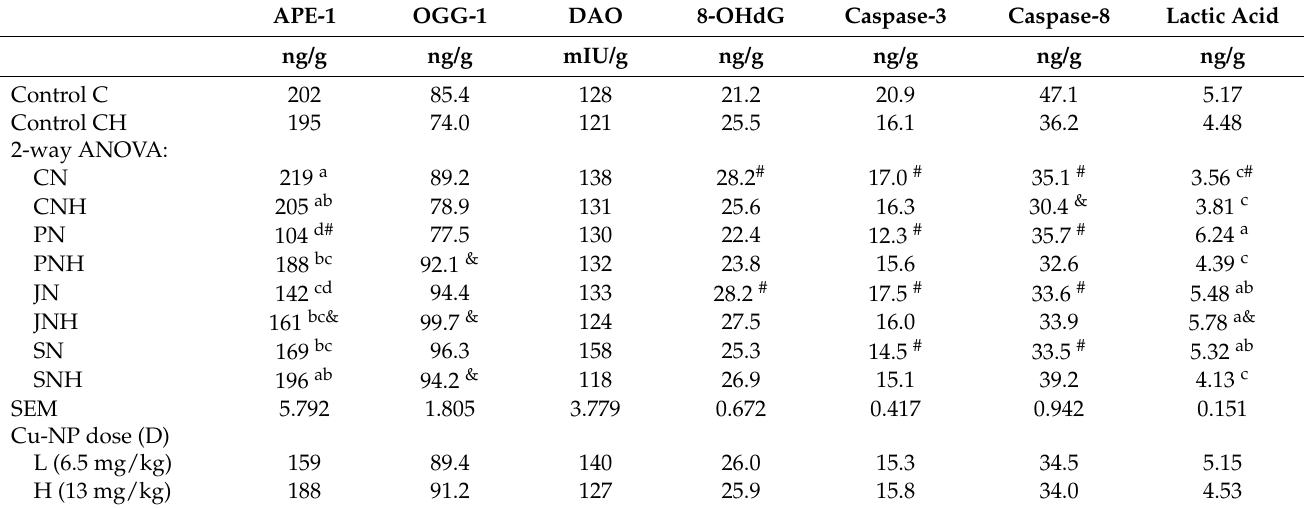
Table 6. Small intestinal biochemical parameters in rats fed experimental diets (n = 10 per group)